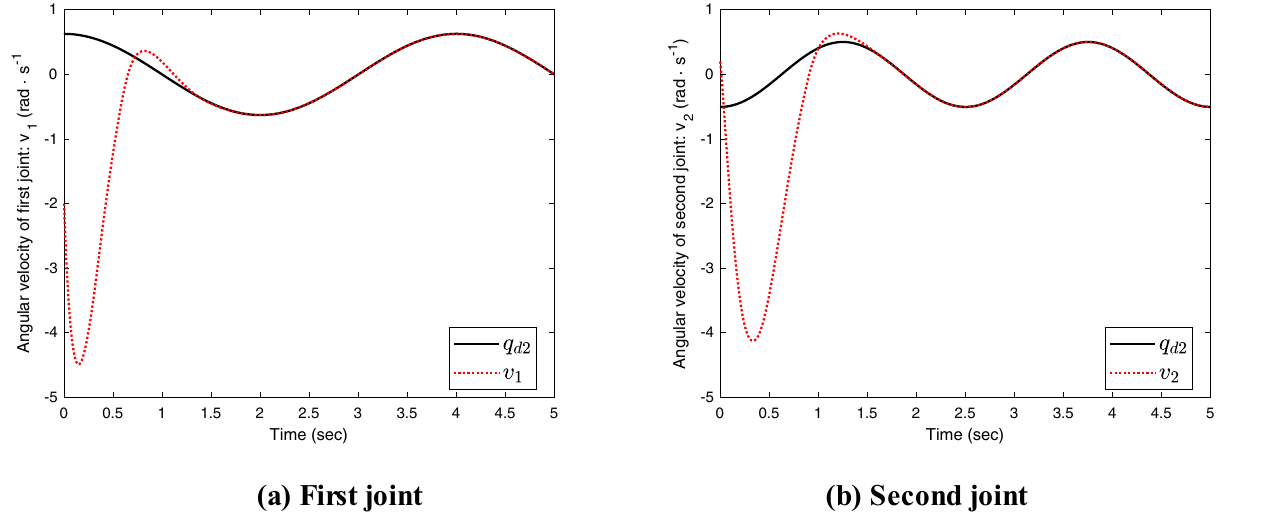
Fig. 6 Plots of velocities ̇ q d 1 , v 1 of first joint and ̇ q d 2 , v 2 of second joint